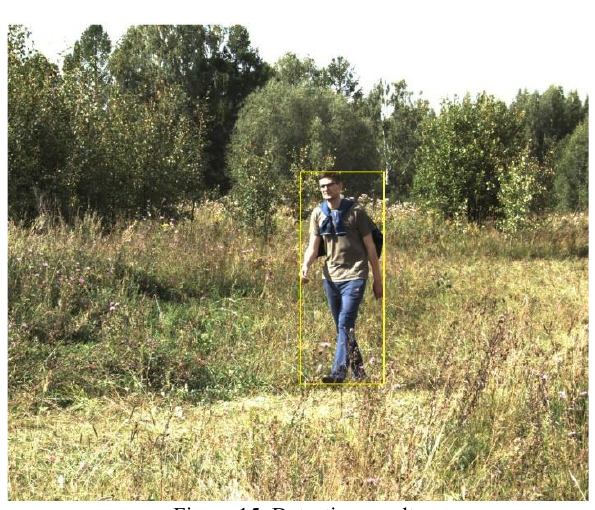
Figure 15. Detection